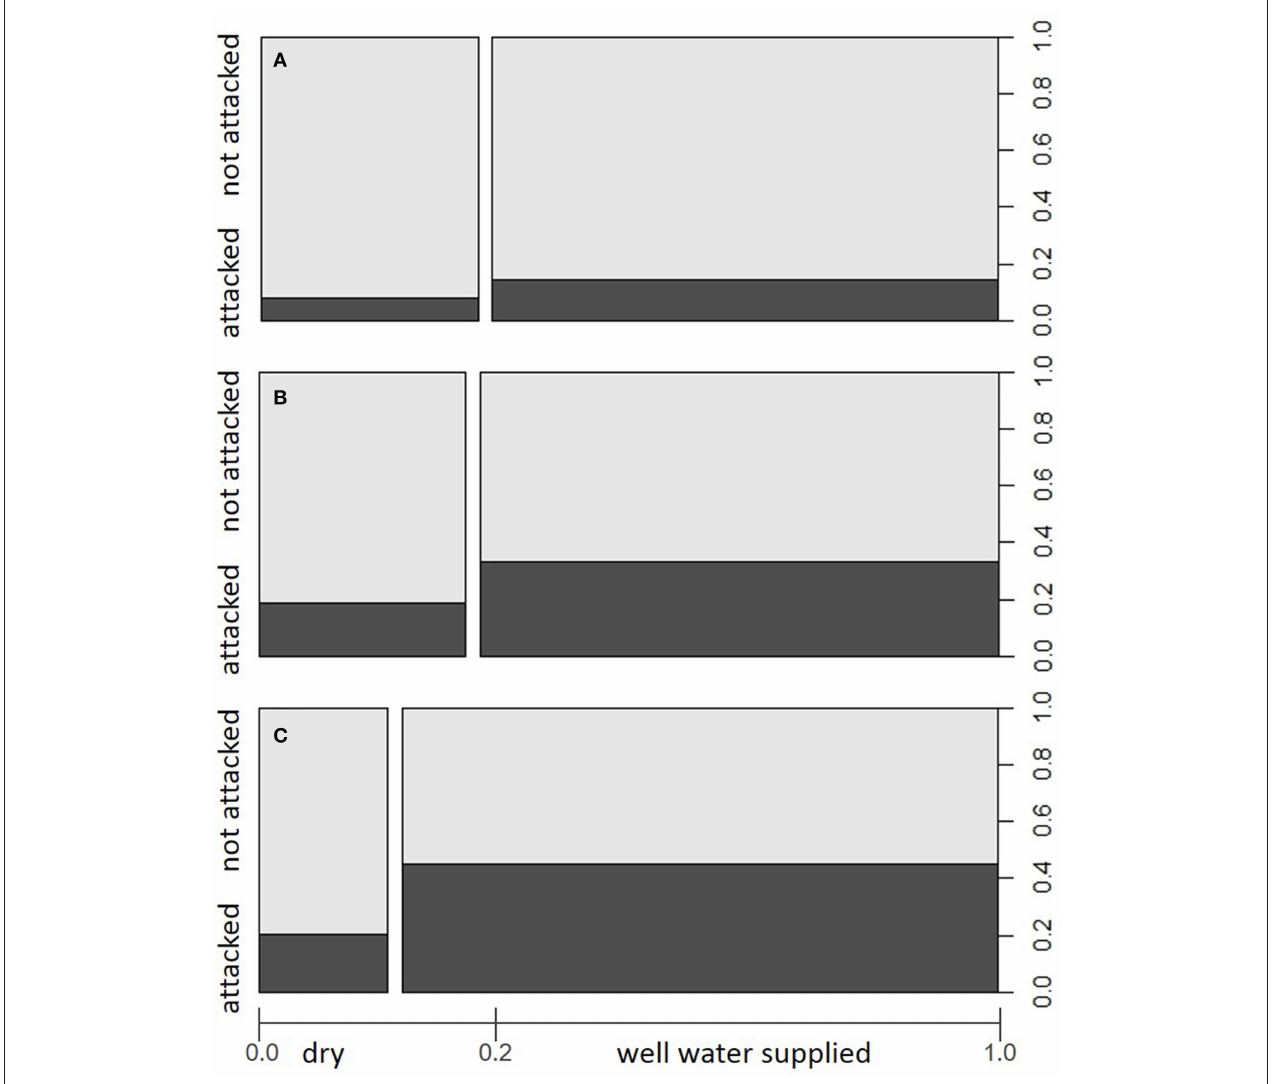
FIGURE 3 | Proportions of forest stands attacked/not attacked by I. typographus in the period 2015–2016 within site categories dry and better water supplied with regard to (A) total study area (i.e., all examined Austrian Federal Forests (ÖBf) forest enterprises), (B) forest enterprise WV, and (C) forest enterprise TIV. The width of bars along the x-axis represents the relative share of site categories among examined forest